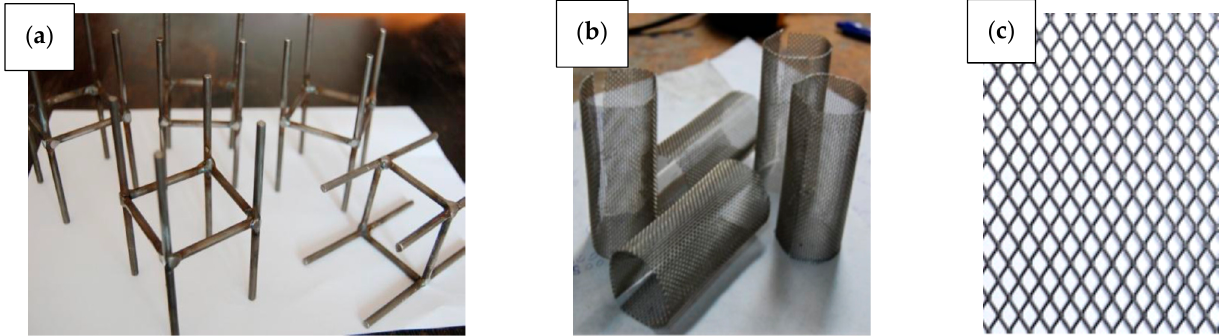
Figure 1. Reinforcement elements: ( a ) steel wire element, ( b ) cylindrically shaped steel mesh, ( c ) flat steel mesh.